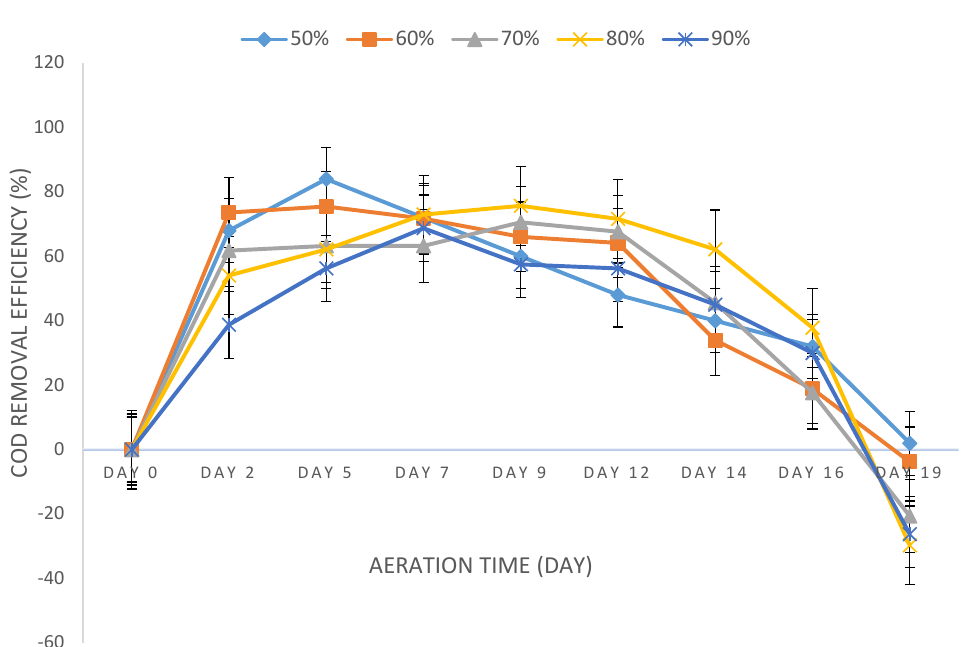
Figure 4. The effect of wastewater mixing ratio on COD removal Figure 4. The e ff ect of wastewater mixing ratio on COD removal e ffi ciency.